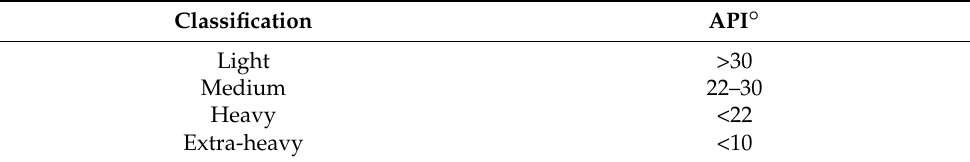
Table 6. Petroleum classification per API ◦ adapted from references [6,31].